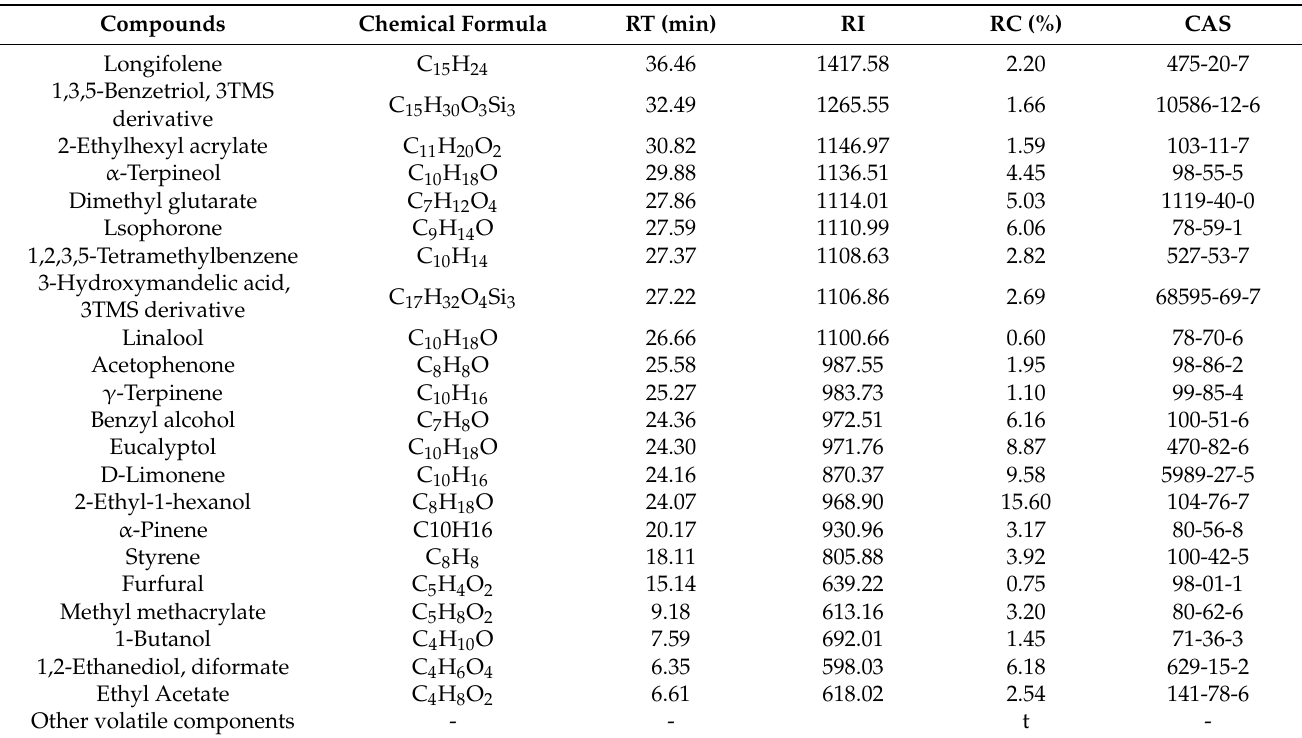
Table 2. Main volatile components of coriander plants.